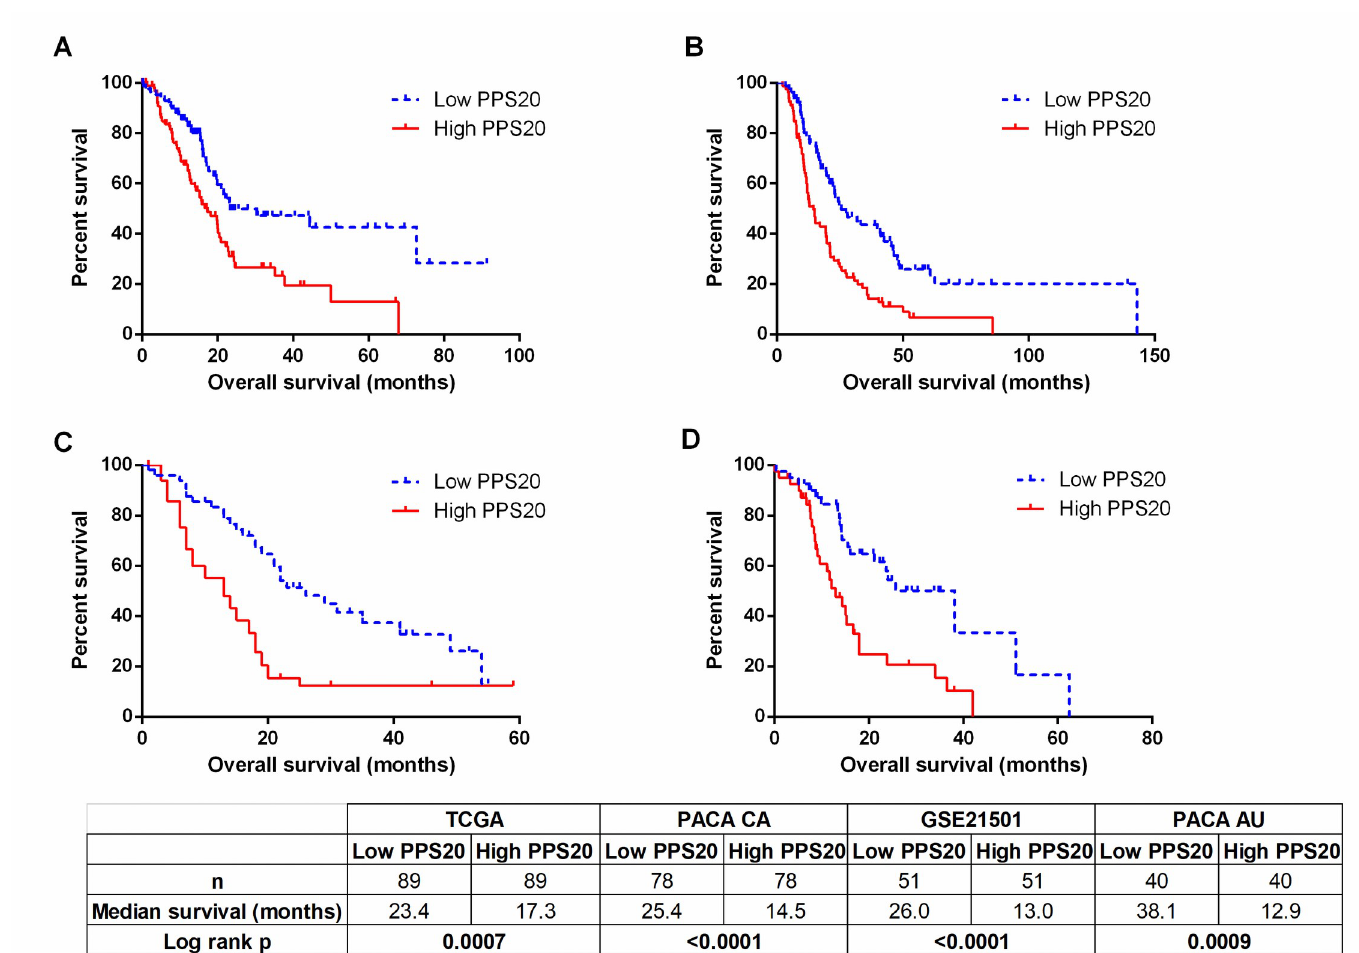
Fig 1. Prognostic stratification by PPS20 in discovery cohorts. Kaplan Meier graphs based on PPS20 for TCGA (A), PACA-CA (B), GSE21501 (C), PACA-AU (D). Cut- off for the score is the median in all cohorts. Statistics are given below the figure.